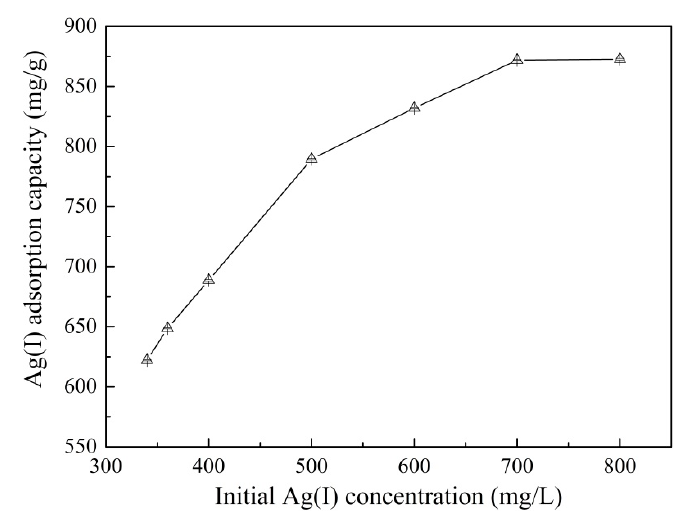
Figure 5. Effect of initial Ag + concentration on the adsorption. Table 2. Comparison of adsorption capacity for Ag + with adsorbents in literatures.